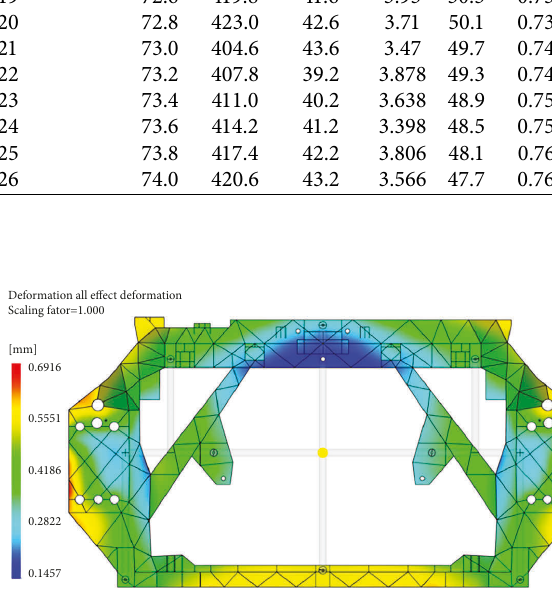
Figure 18: Acloud map of minimum warpage.